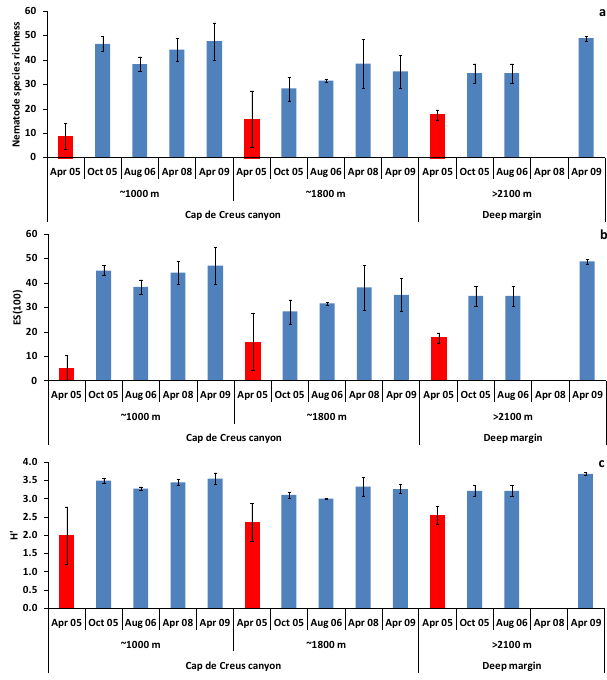
Fig. 4. Spatial and temporal variation in nematode specie richness (a) , expected species number [ES ( 100 ) ] (b) and Shannon’s H 0 val- ues (c) in the Cap de Creus Canyon and deep margin. Red bars indicate Pusceddu et al. Major consequences of an intense Dense Shelf Water Cascading event on deep-sea benthic trophic conditions and meiofaunal biodiversity